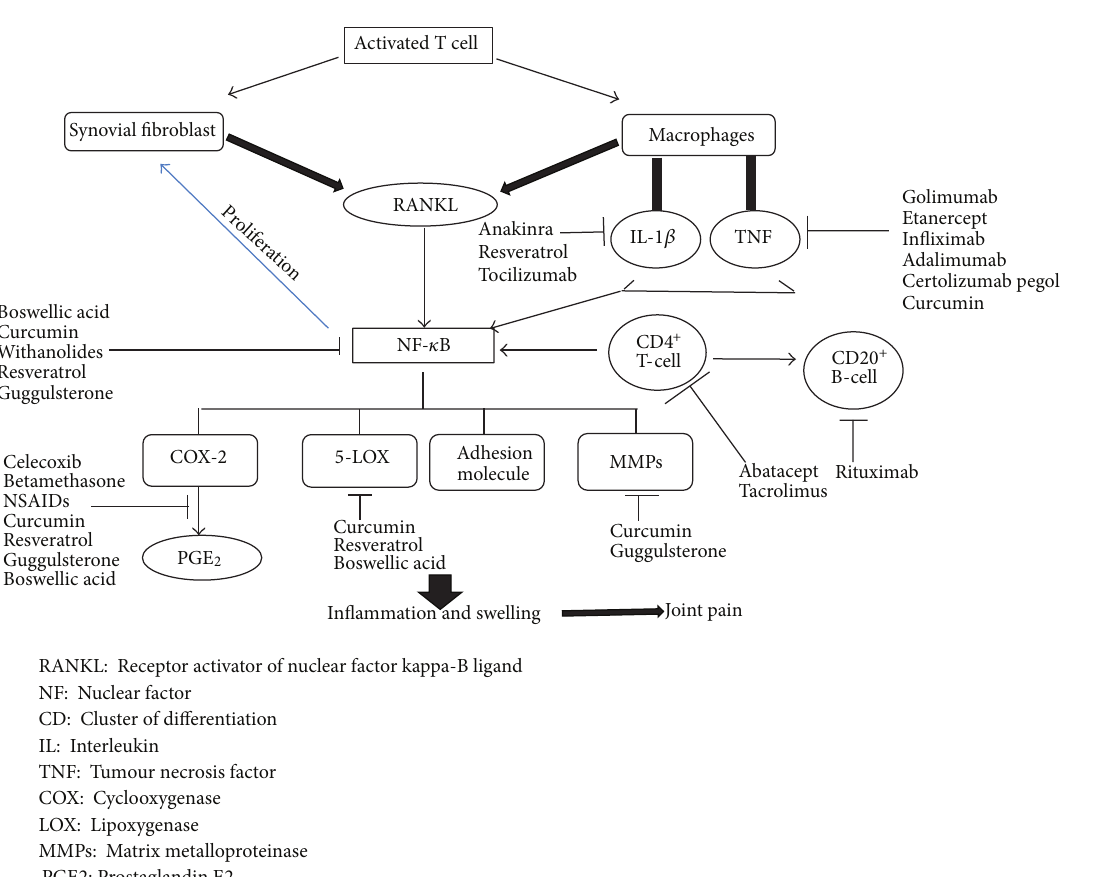
Figure 1: Etiology of rheumatoid arthritis and potential therapeutic agents and their sites of